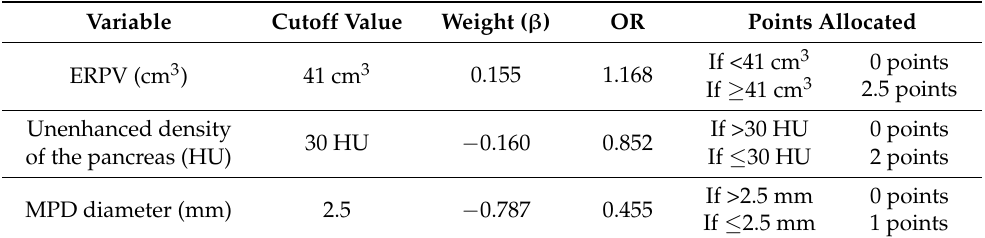
0 points If <41 cm 3 2.5 points If ≥ 41 cm 3 If >30 HU 0 points If ≤ 30 HU 2 points If >2.5 mm 0 points If ≤ 2.5 mm 1